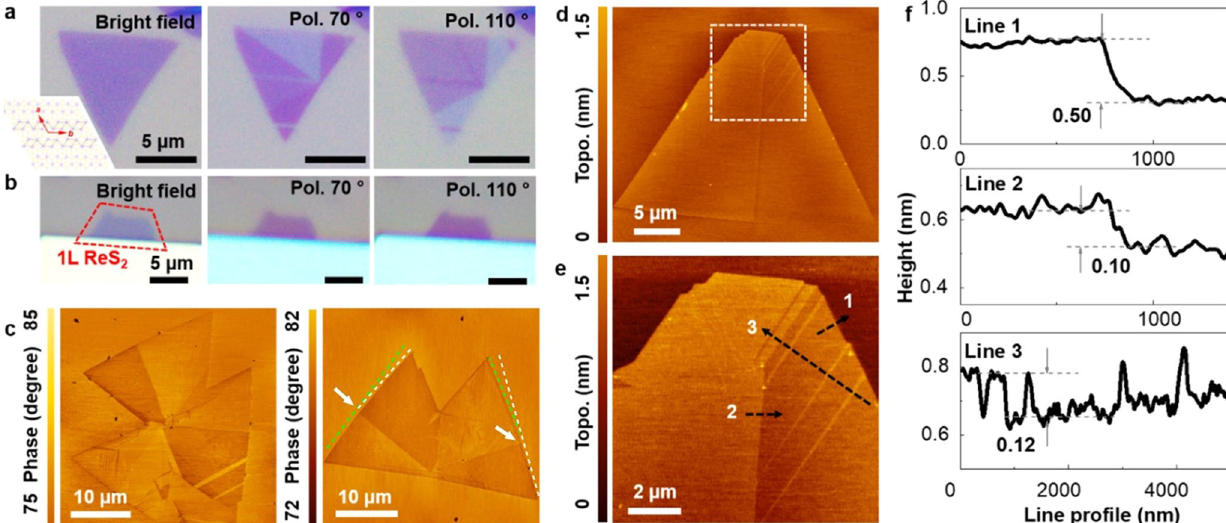
Fig. 1 The martensite-like domain structures in 2D ReS 2 . a , b The color optical images under bright fi eld, polarized 70° and 110° for CVD-grown 1L-ReS 2 transferred on 300 nm SiO 2 /Si substrate, and mechanical exfoliated ReS 2 on 300 nm SiO 2 /Si substrate, respectively. The inset shows the crystal structure model of monolayer (1L) ReS 2 with chain-like structures (dashed black lines). c , d The DFM phase and topography images of monolayer ReS 2 as grown on mica (ReS 2 /mica). e The magni fi ed DFM topography image corresponding to the white dashed square in d . f The line pro fi les corresponding to the black dashed lines in e